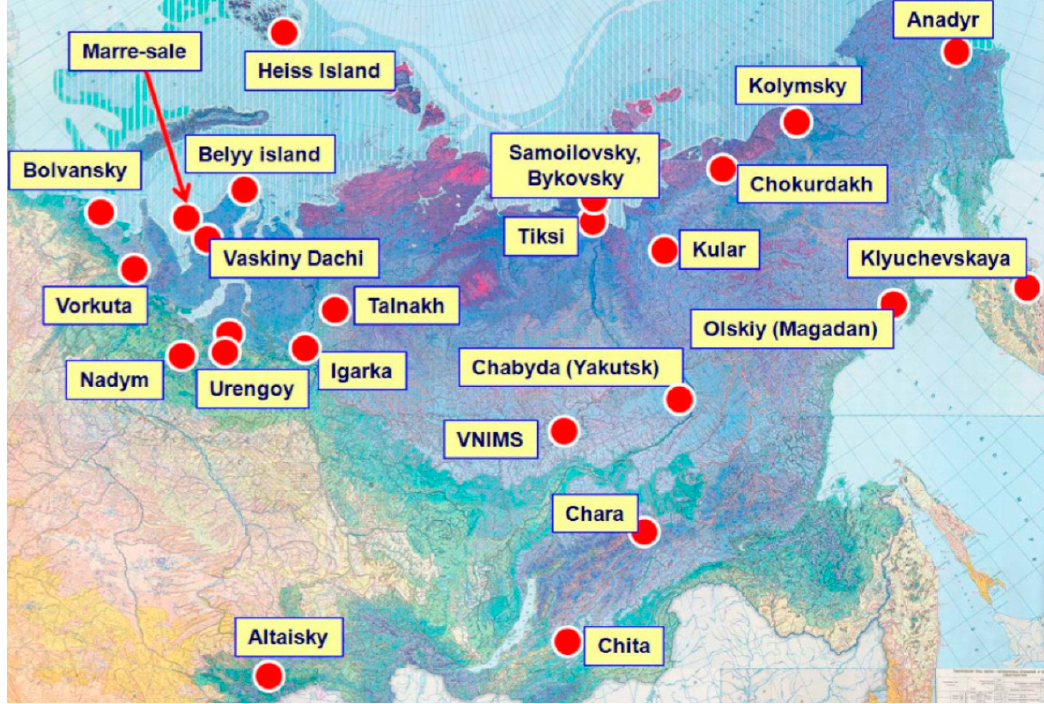
Figure 2. The location of the reference test sites within the permafrost zone.